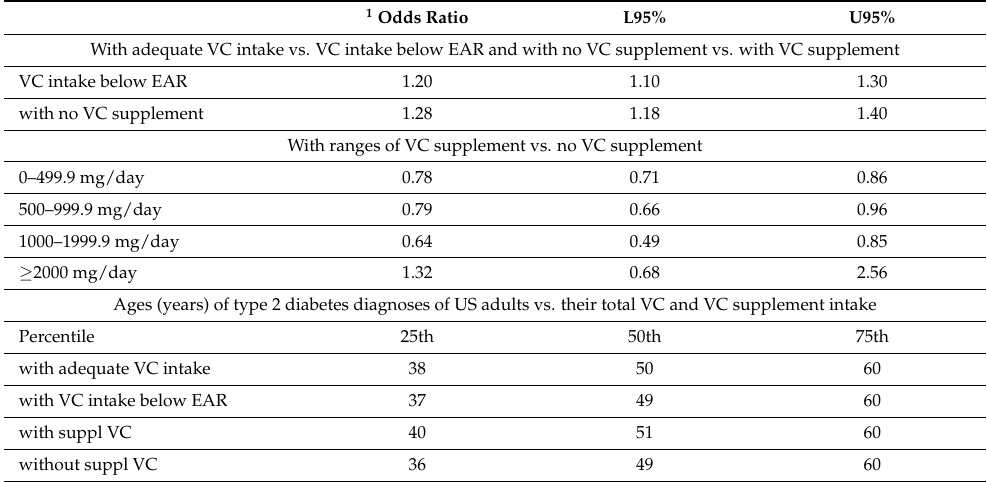
Table 4. Odds ratios of VC intake, VC supplement use, and age percentiles of type 2 diabetes diagnoses of US